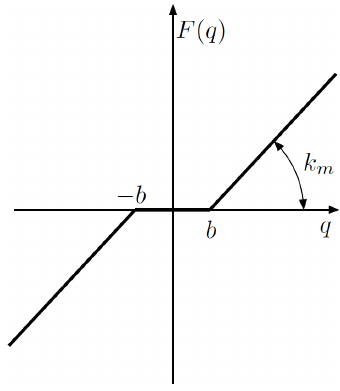
Figure 8. Nonlinear trend of the elastic contribution as described in